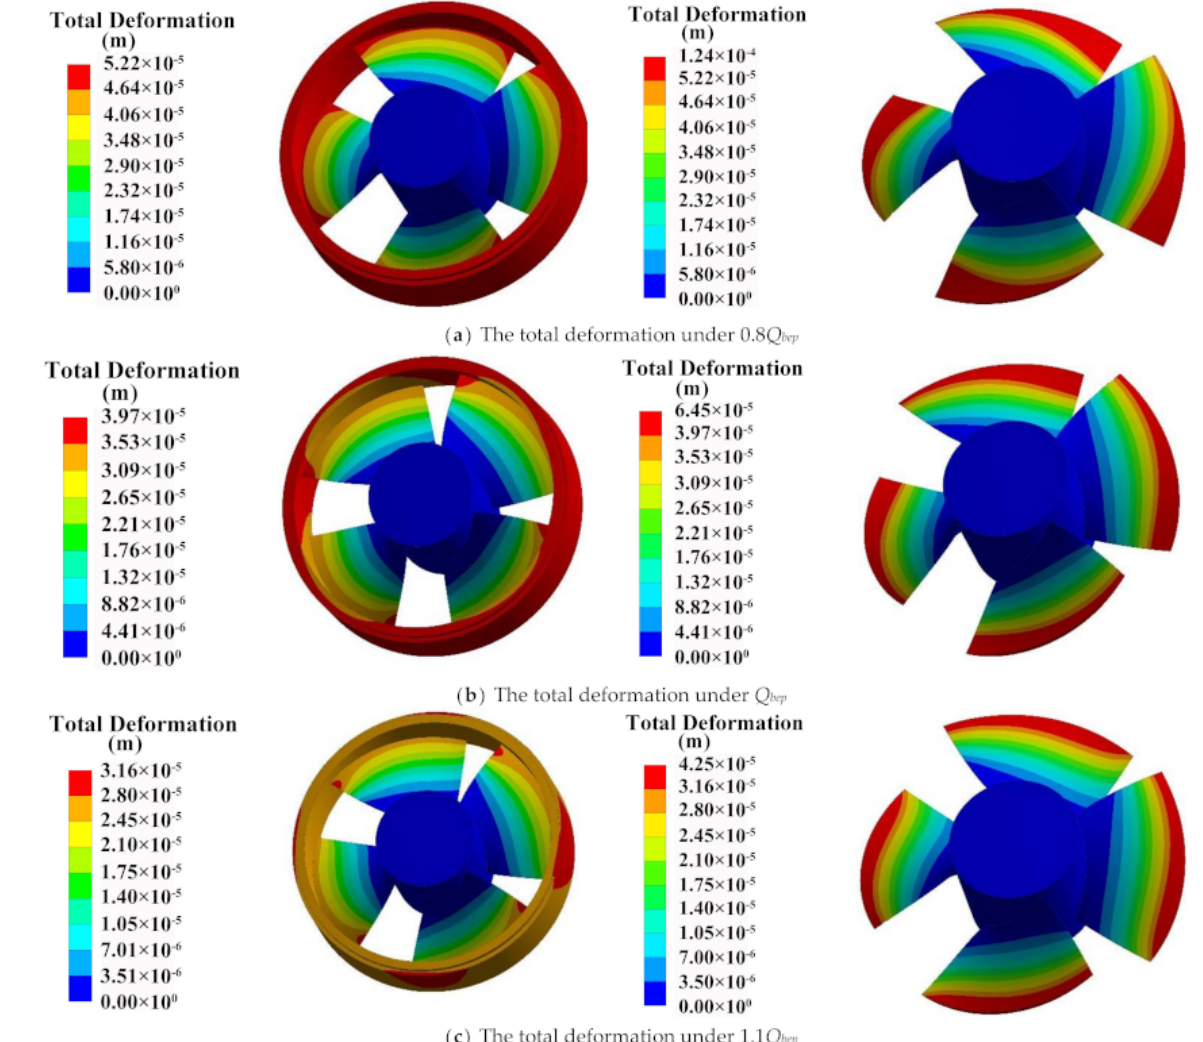
Figure 10. Deformation distribution of the blade PS between the full tubular pump and axial-flow pump: ( a ) the total deformation under 0.8 Q bep , ( b ) the total deformation under Q bep , ( c ) the total deformation under 1.1 Q bep